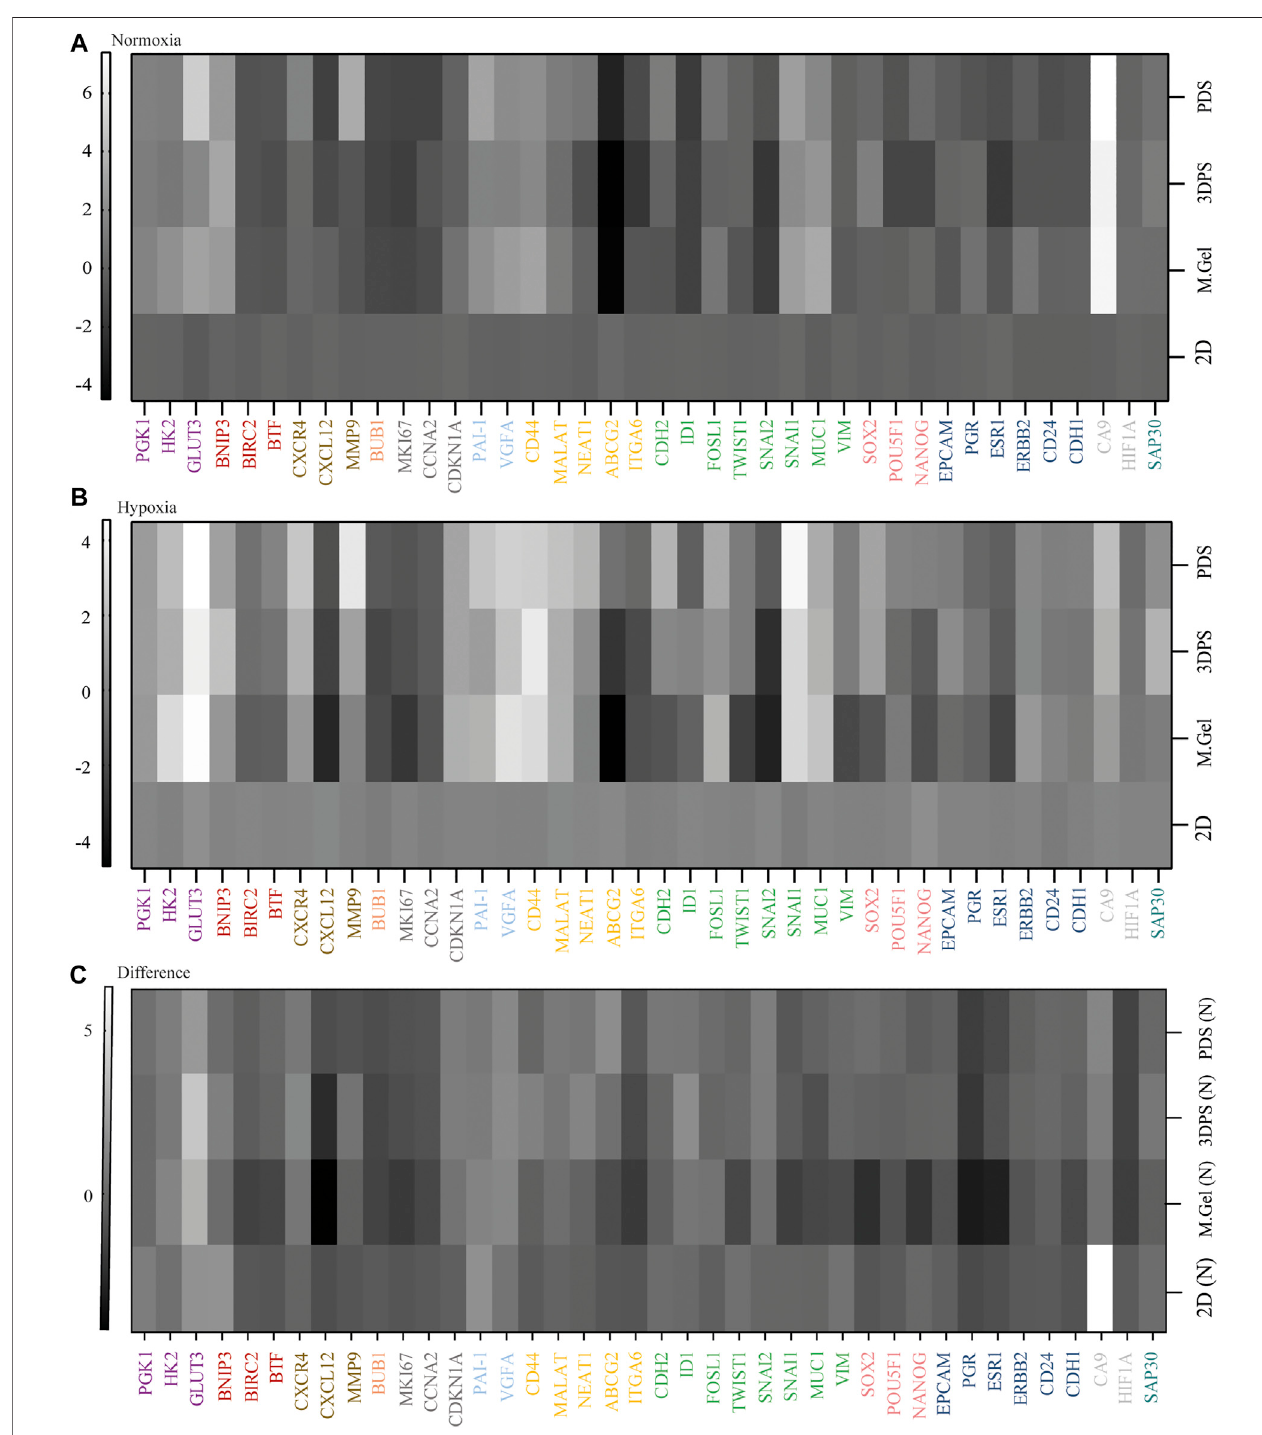
FIGURE3| Heatmapsrepresentingrelativegeneexpressionlevels. (A,B) Geneexpressionlevelsofcellsculturedinnormoxia (A) orhypoxia (B) inpatient-derived scaffolds (PDS), 3D printed scaffolds (3DPS), and Matrigel (M.Gel) relative to 2D ( n (cid:2) 3). (C) Difference in gene expression levels between hypoxia and normoxia. Color codes: metabolism (purple), cell death (red), invasion (brown), cell division (orange), proliferation (dark gray), angiogenesis (light blue), cancer stemness (yellow), epithelial – mesenchymal transition (green), pluripotency (pink), differentiation (dark blue), hypoxia (gray), and epigenetics (dark green).